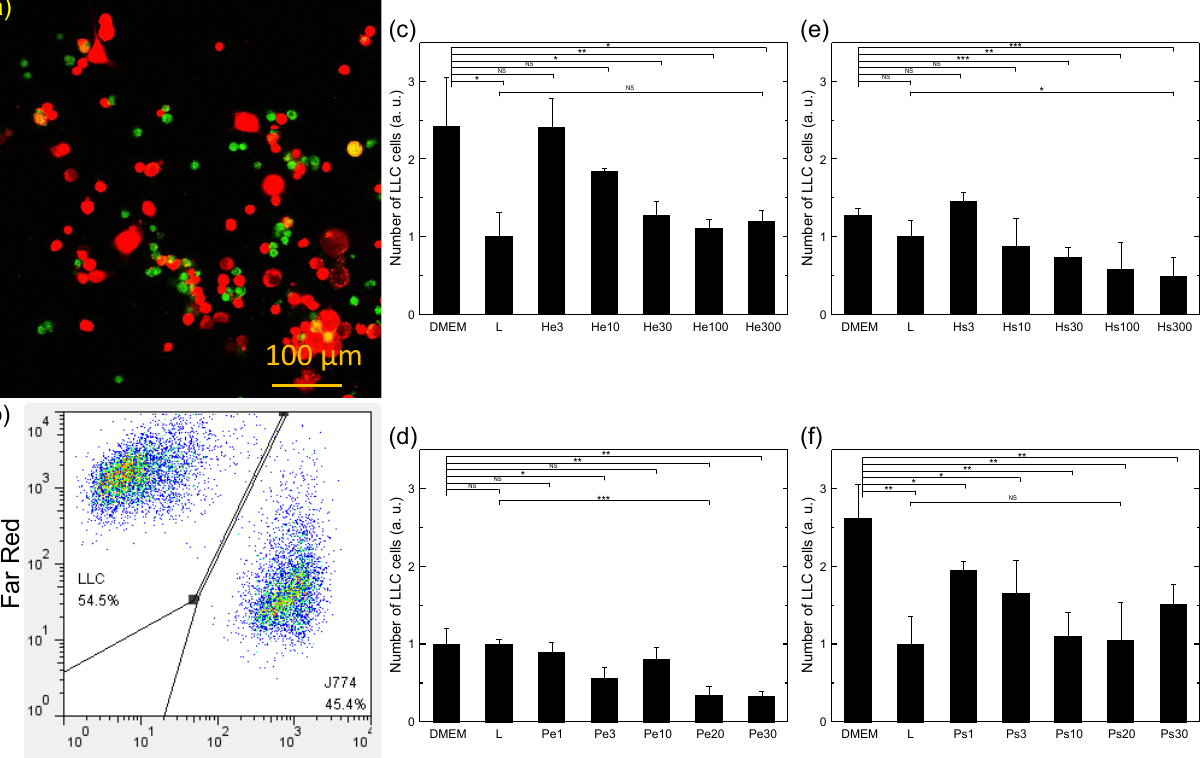
Figure 7. Numbers of viable LLC cells after co-culturing with macrophages and treated with various vaccines for 48 h. ( a ) Fluorescence image of the co-cultured LLC cells (red) and macrophages (green) at 48 h after plating without any vaccine. ( b ) Flow cytometry dot graph of the co-cultured LLC cells (Far Red) and macrophages (CFSE) at 48 h after plating without adding the vaccine. ( c ) Comparison of H 2 O 2 -extrusion vaccines with various doses. ( d ) Comparison of PDT-extrusion vaccines with various doses. ( e ) Comparison of H 2 O 2 -supernatant vaccines with various doses. ( f ) Comparison of PDT-supernatant vaccines with various doses. The initial ratio of the number of LLC cells and macrophages was 1:2. DMEM: without the vaccine; L: without